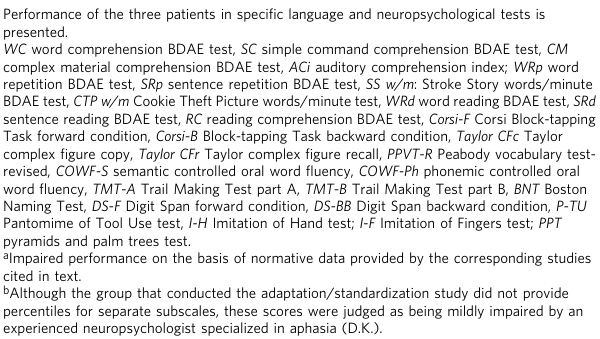
Pantomime of Tool Use test, I-H Imitation of Hand test; I-F Imitation of Fingers test; PPT pyramids and palm trees test. a Impaired performance on the basis of normative data provided by the corresponding studies cited in text. b Although the group that conducted the adaptation/standardization study did not provide percentiles for separate subscales, these scores were judged as being mildly impaired by an experienced neuropsychologist specialized in aphasia